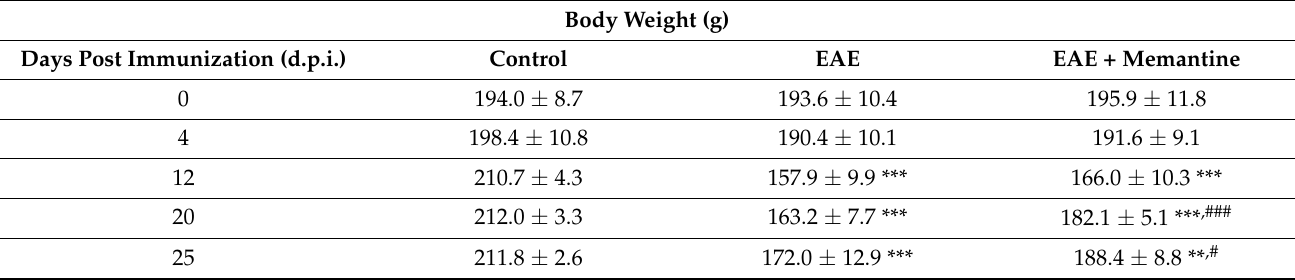
Table 1. Changes in the body weight of experimental rats in different phases of EAE. Body Weight (g) Days Post Immunization